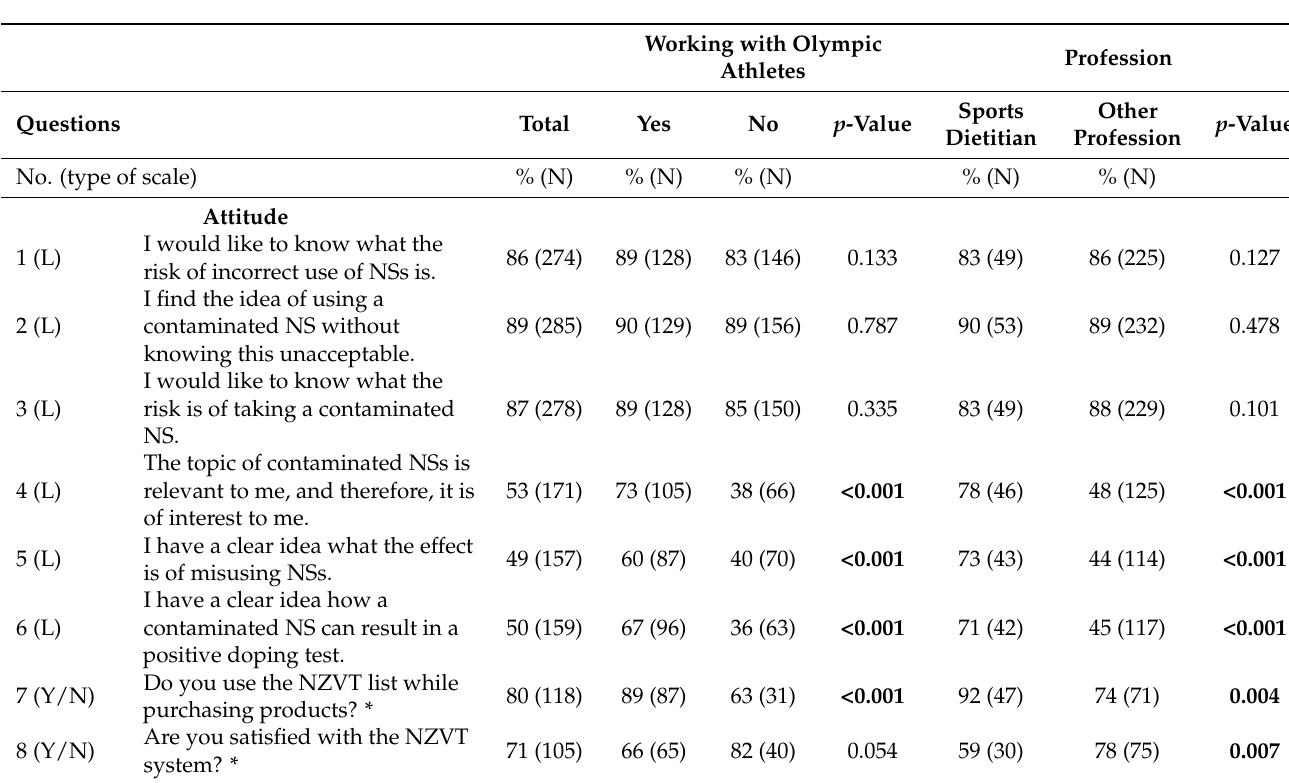
Table 3. Self-reported attitude about contaminated nutritional supplements (NSs) and dietary sup- plement third-party testing (% and N) for the total group, professionals working or not working with Olympic athletes, and sports dietitians vs. other